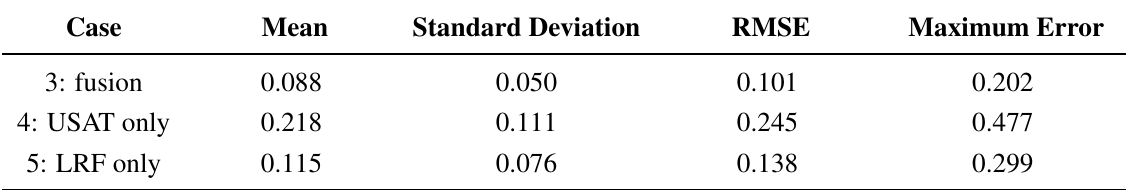
Table 6. Mean, standard deviation, root mean square and maximum of distance error